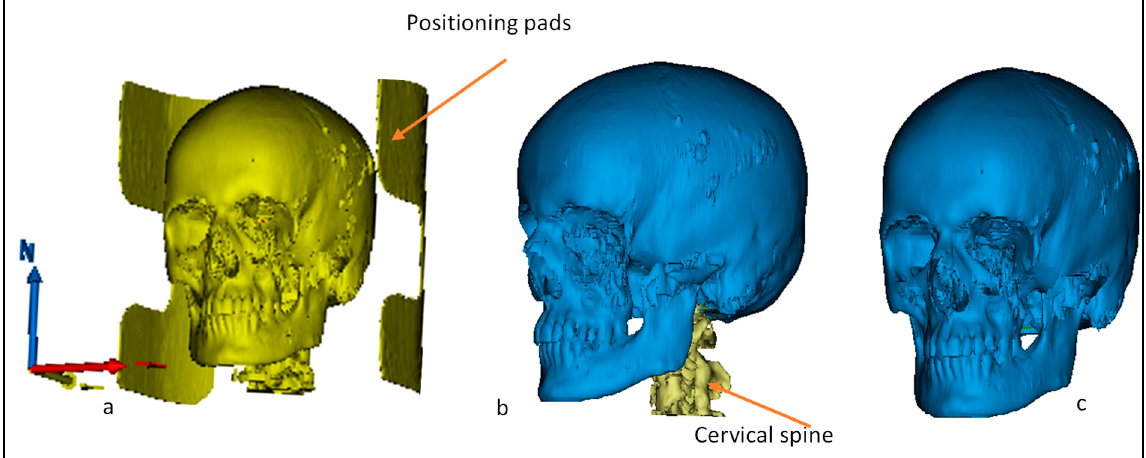
Figure 2. Steps involved in the segmentation of ( a ) positioning pads and ( b ) cervical spine to obtain the region of interest—( c ) skull.